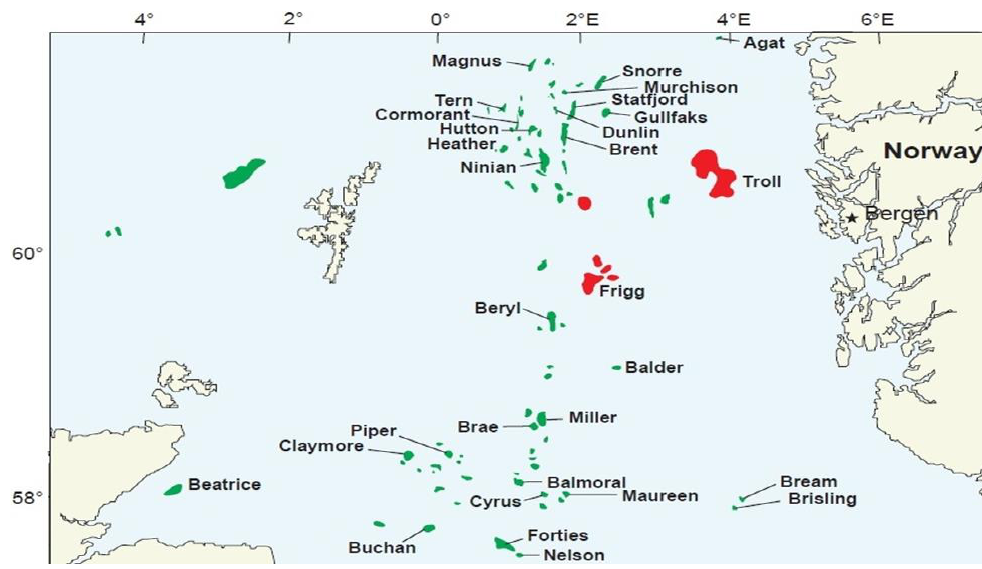
Figure 2. Transboundary Frigg deposit [21].